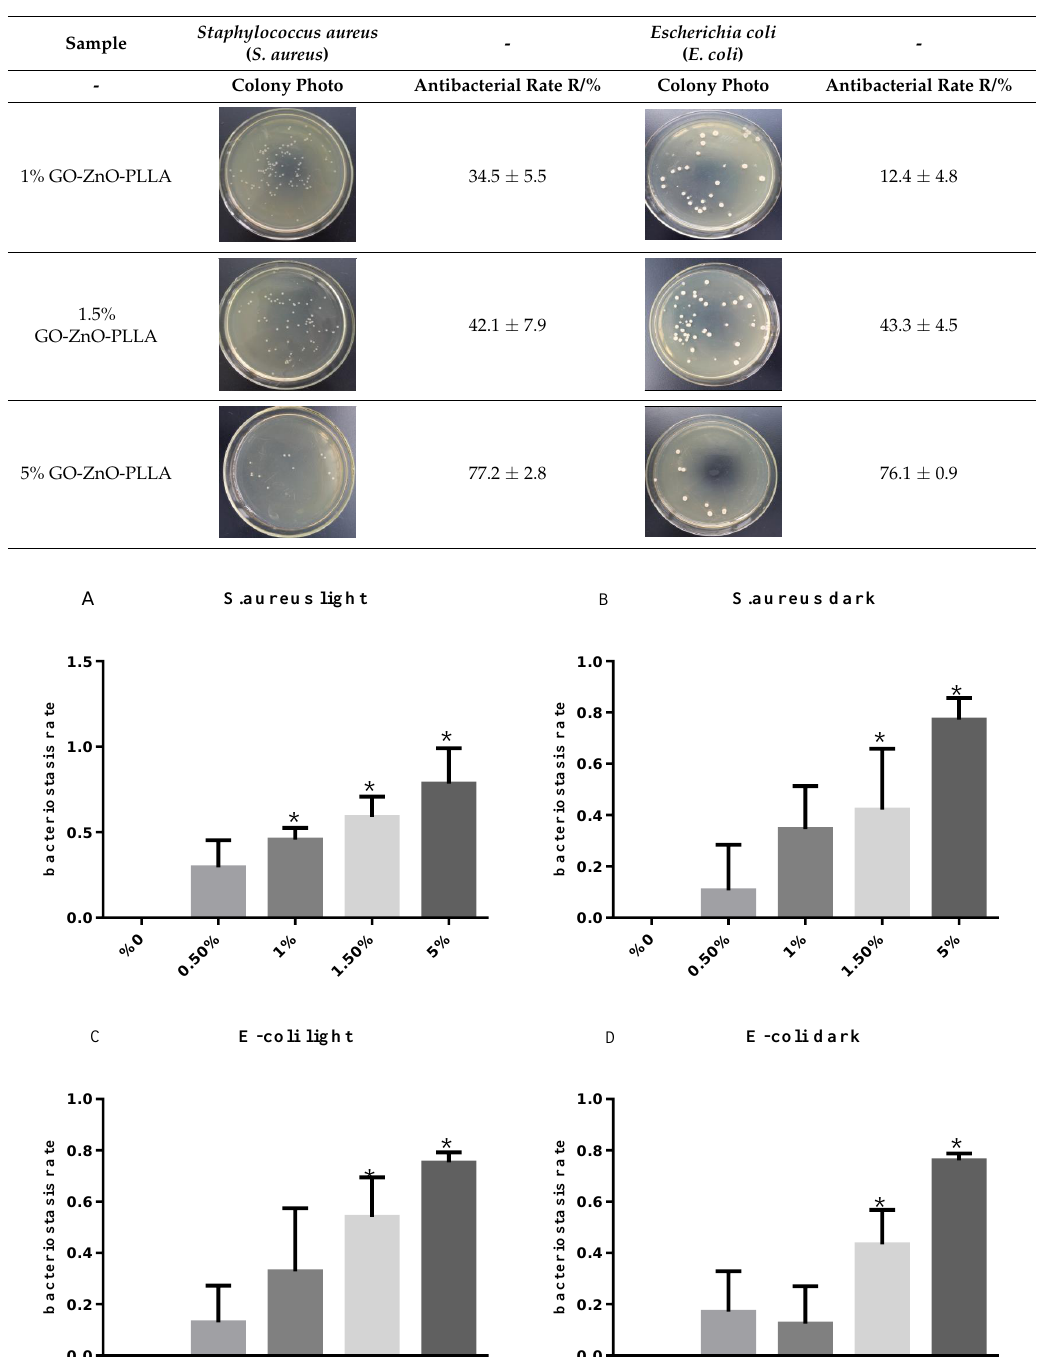
Figure 13. Statistical plots of the antibacterial rates of ( A ) inhibition of samples against S. aureus under light exposure, ( B ) inhibition of samples against E. coli under light exposure, ( C ) inhibition of samples against S. aureus without light exposure, and ( D ) inhibition of samples against E. coli without light exposure. * indicates a significant difference with 0% (PLLA), p < 0.05.